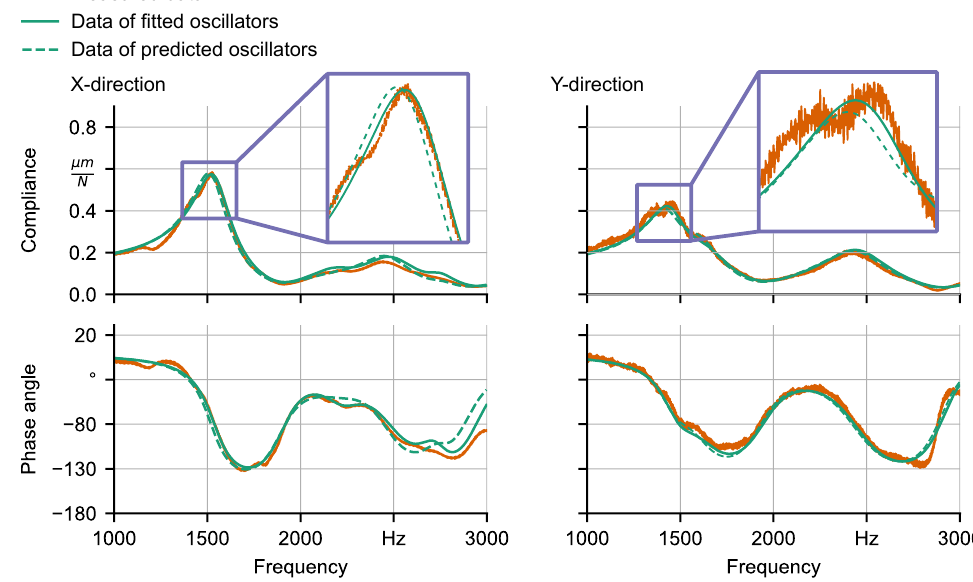
Figure 7. Measured, fitted and predicted FRFs according to the second learning objective for the pose P Z,Y,B = ( − 50.0,500.0,0.0 ) and machine tool M 2